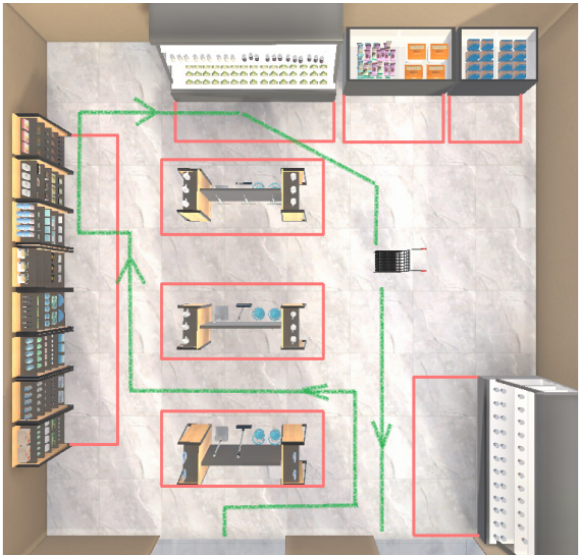
Figure 9. Position-based analysis for VR shopping recommendation (green line is user trajectory).